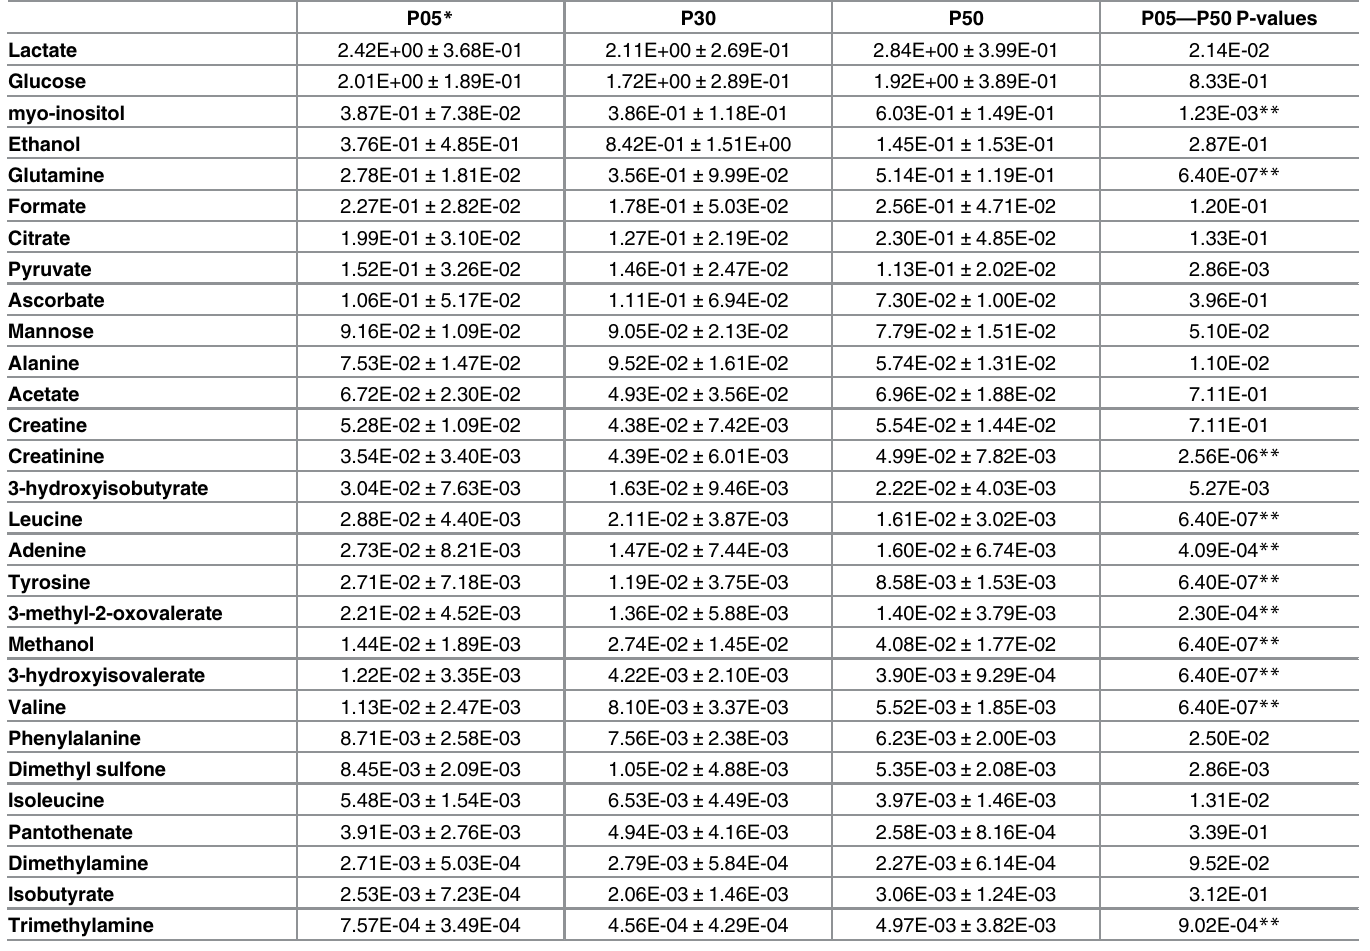
Table 2. Concentration of the molecules quantified by NMR in CSF (mM).